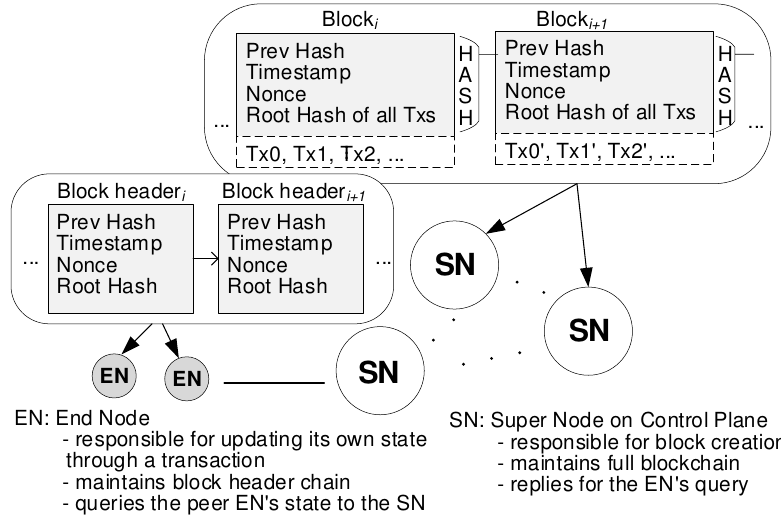
Figure 3. Blockchain-based Security Management (BSM) network